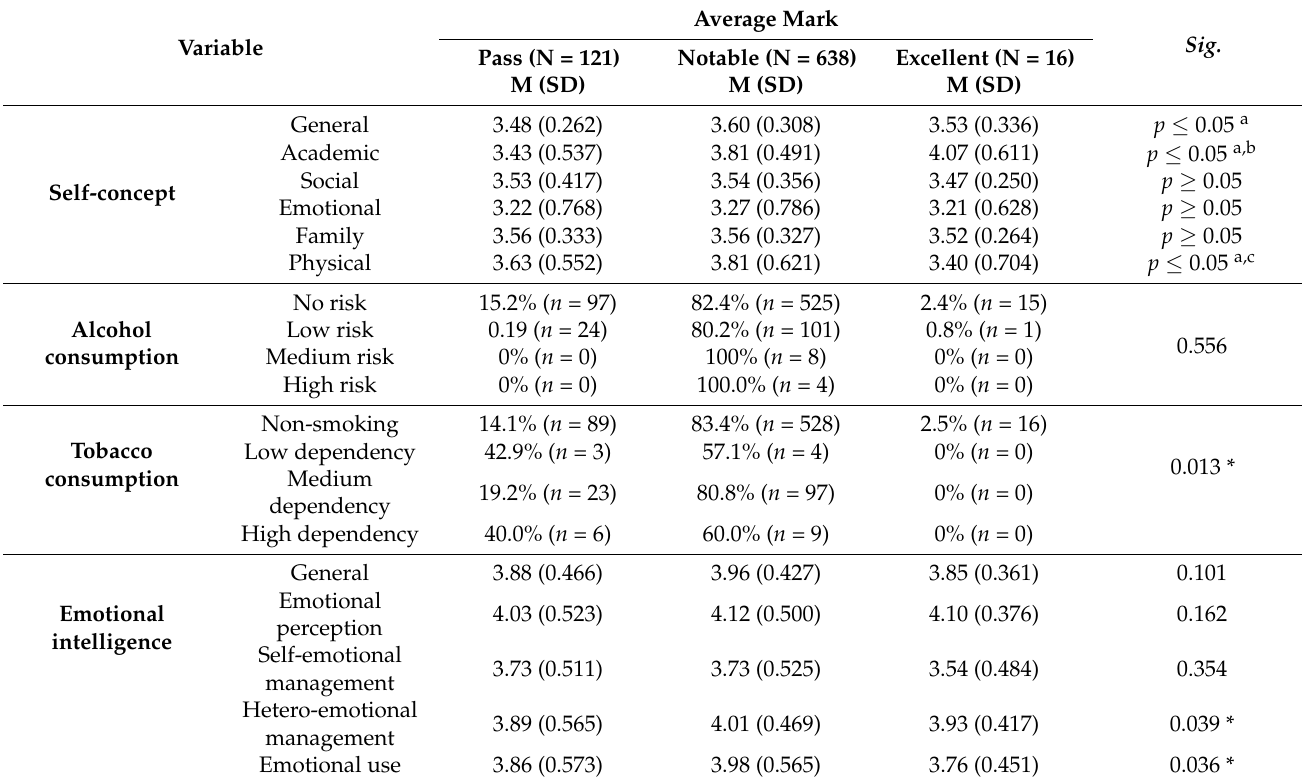
Table 3. Psychosocial factors according to average